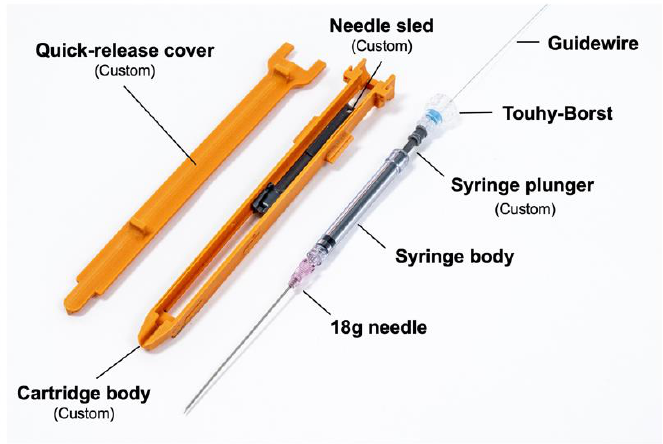
Figure 5. Cartridge and needle assembly for vascular access.